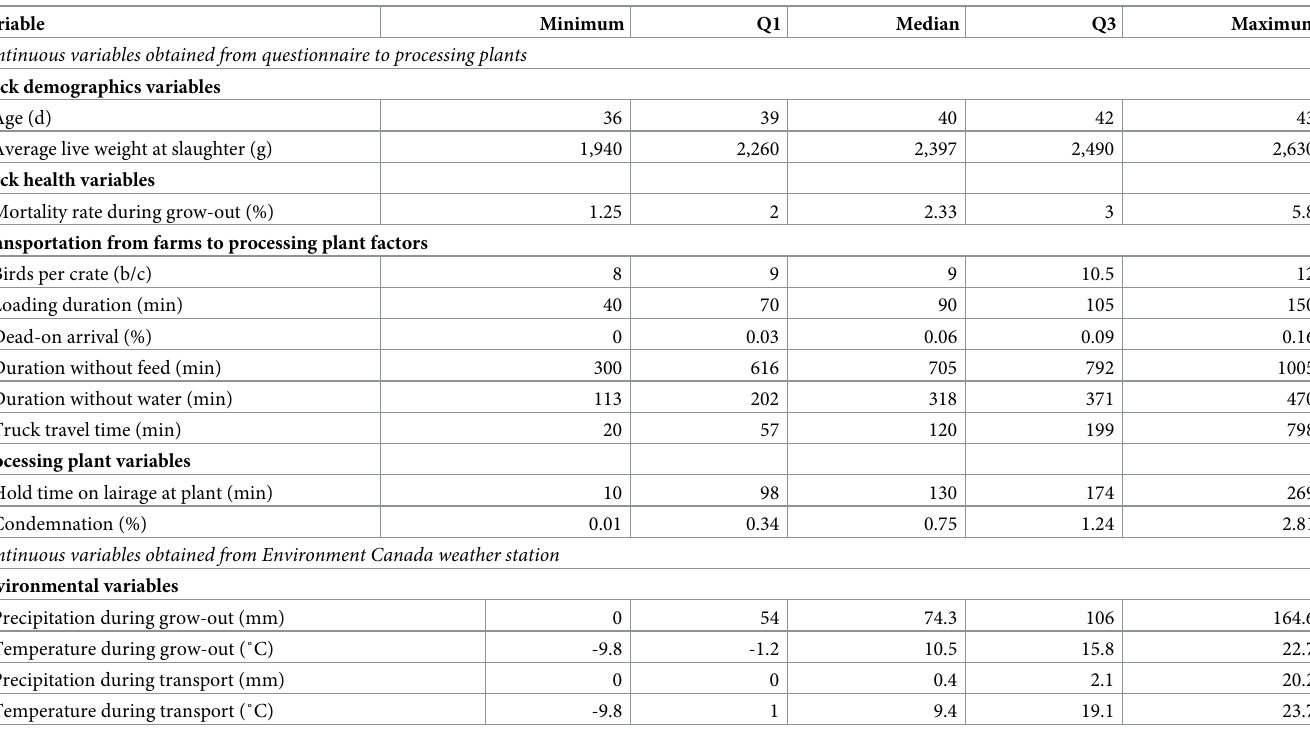
Table 2. Descriptive statistics of 15 continuous variables from 37 chicken broiler flocks surveyed in a study on the occurrence of breast meat myopathies in Ontario, Canada (2019–2020). Variable Minimum Q1 Median Q3